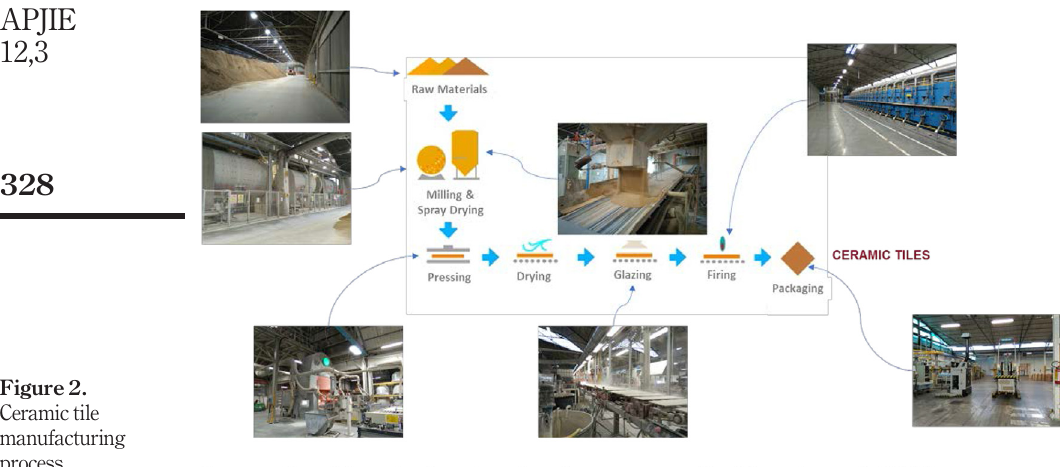
Figure 2. Ceramic tile manufacturing